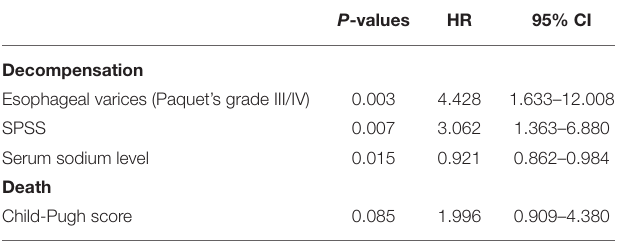
TABLE 4 | Multivariate analysis to determine predictive factors for decompensation and death (propensity-matched study cohort). P -values HR 95%